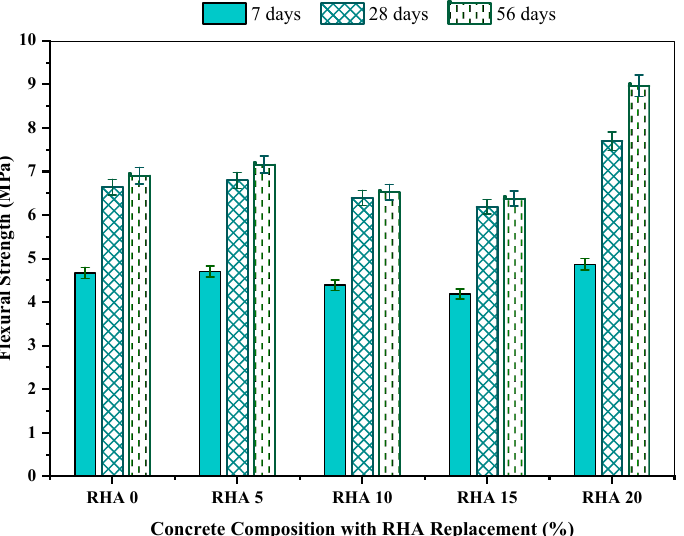
Figure 11. Flexural strength of the concrete incorporating RHA at 7, 28 and 56 days.